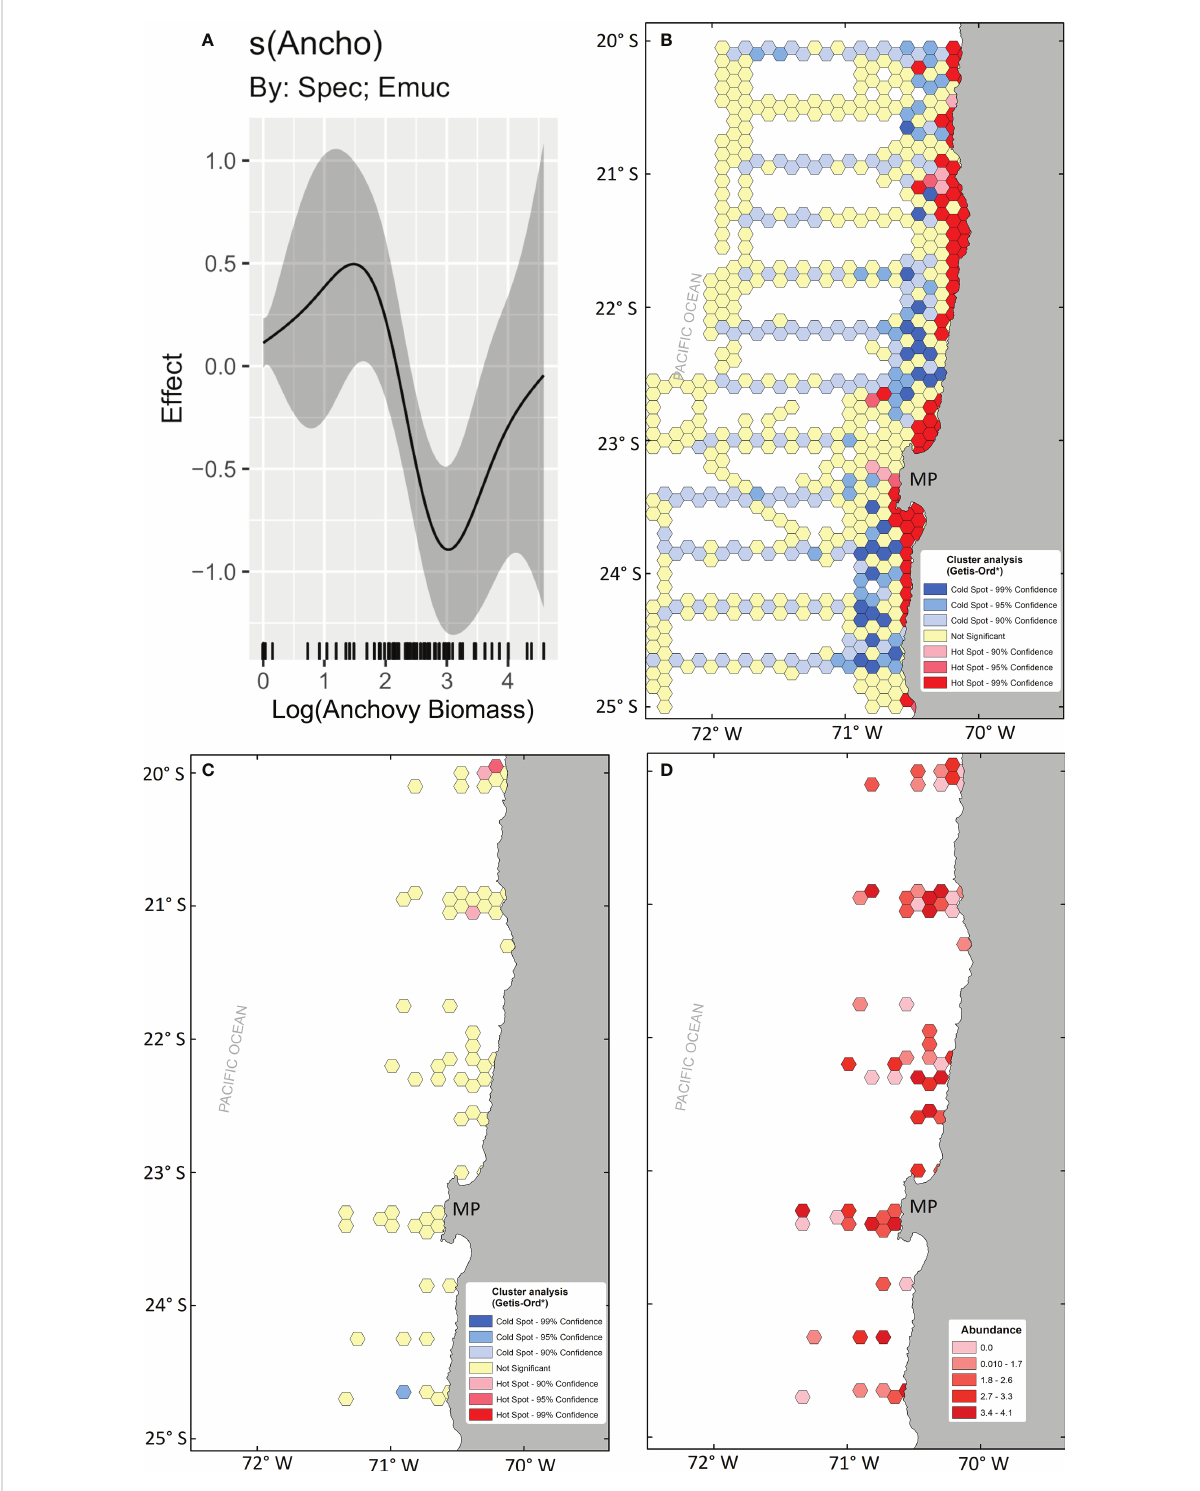
FIGURE 9 Effect of anchovy biomass (m 2 nm -2 ) on E mucronata abundances (smooth function obtained from the HGAM fi nal model) (A) , Getis-Ord local Gi* cluster analysis for anchovy (B) , and E mucronata (C) , and mean abundance map of E mucronata (D)